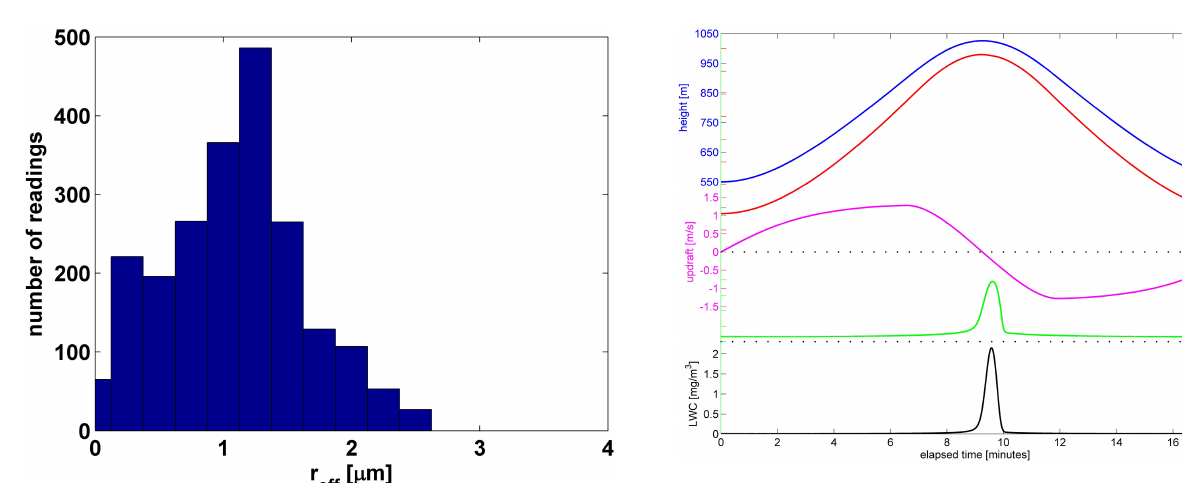
Figure 3. Temporal evolution of an air parcel. Vertical posi- tion (blue), RH and supersaturation (red), updraft (magenta), r eff (green), and LWC (black).